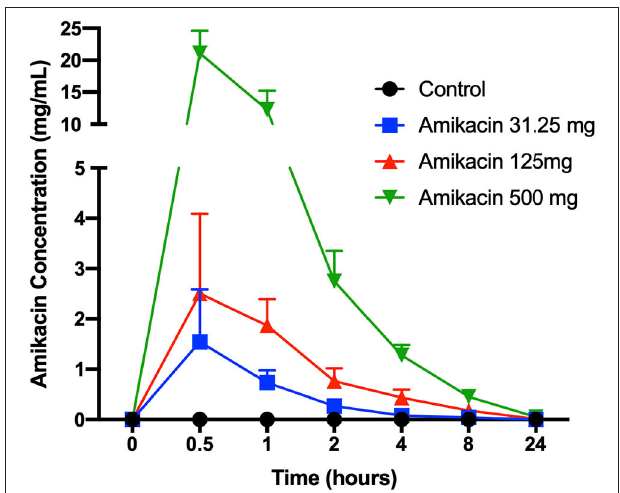
FIGURE 2 | Synovial fluid amikacin concentrations over time following a single intra-articular administration of amikacin at three concentrations. Synovial fluid amikacin concentrations ( n = 3 horses per group) were determined by high-pressure liquid chromatography/mass spectrometry and expressed as the mean ± SD.